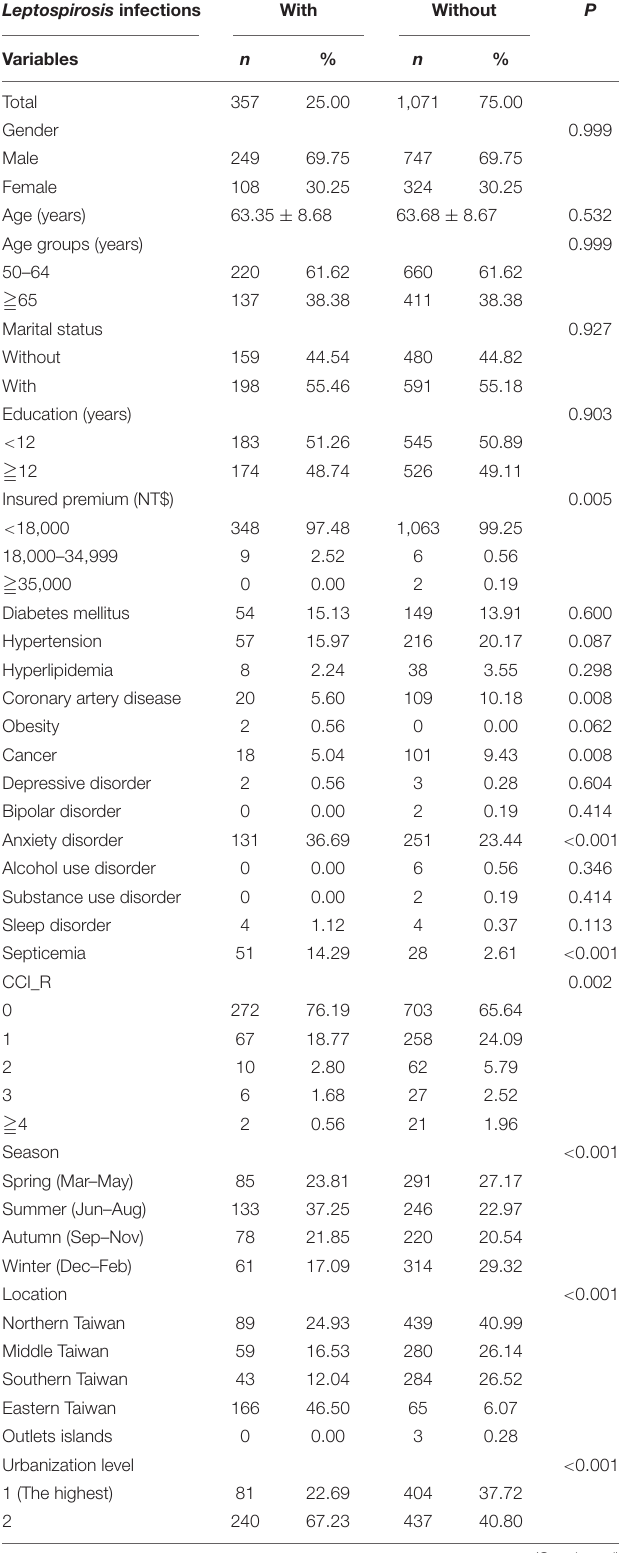
TABLE 1 | Characteristics of study at the baseline. Leptospirosis